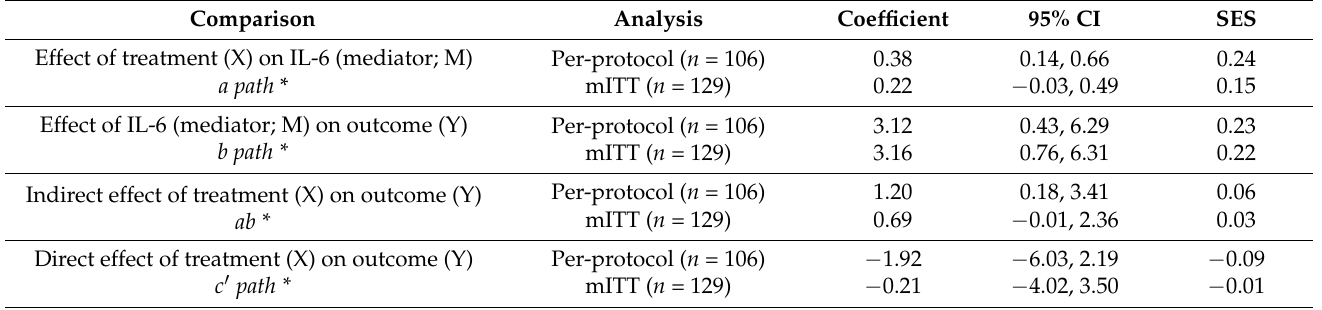
Figure 2. IL-6 levels at baseline and after treatment (five weeks after randomisation) in participants taking placebo and metyrapone. Log-transformed mean values of interleukin 6 (IL-6) before and after treatment in the metyrapone group (significant increase over time) and placebo group (no significant change over time). Error bars represent standard deviation (SD). Table 4. Mediation effects of IL-6 changes on response to metyrapone versus